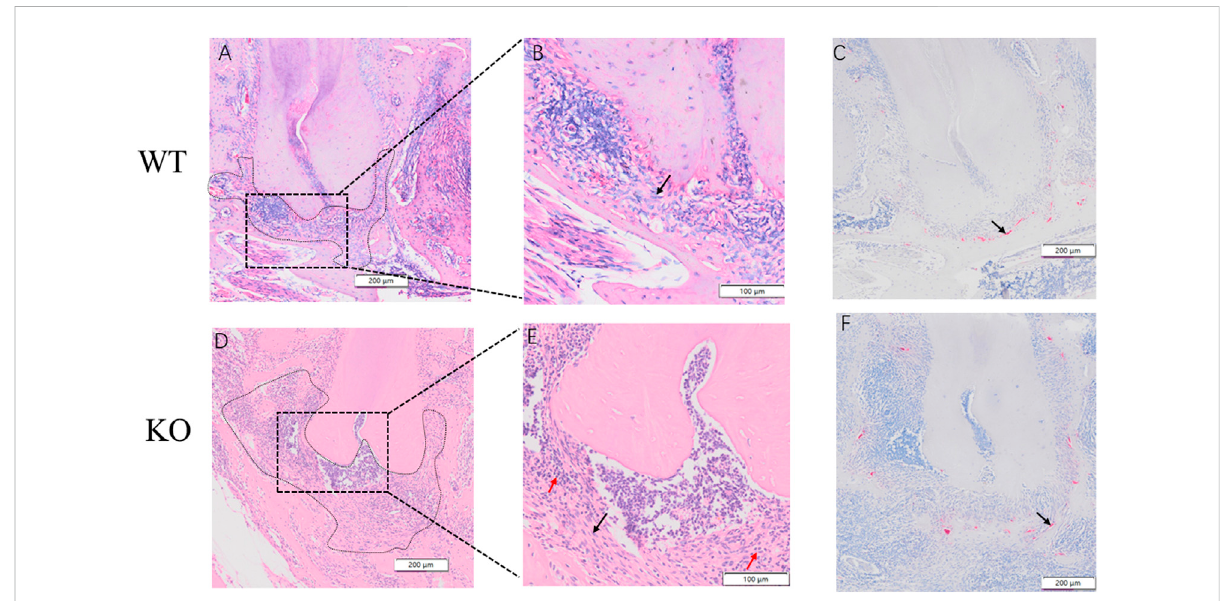
FIGURE 9 Hematoxylin and eosin (H&E) and Tartrate-resistant acid phosphatase (TRAP) staining of dentoalveolar bone in WT an KO mice. Periapical regions and fi broblasts (black arrow) of WT mice were observed by optical microscopes in (A) and (B) . Periapical regions, neutrophils (red arrow) and fi broblasts (black arrow) of KO mice were observed under optical microscopes in (D) and (E) . An osteoclastic cell can be observed in (C) an (F) (black arrow). Scale bars: 200 μ m, 100 μ